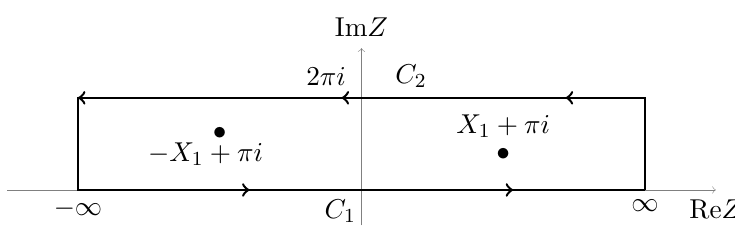
Figure 2 . A contour for the evaluation of (C.1). Assuming | Im [ X 1 ] | < π , there are two simple poles at Z = ± X + πi inside the 1